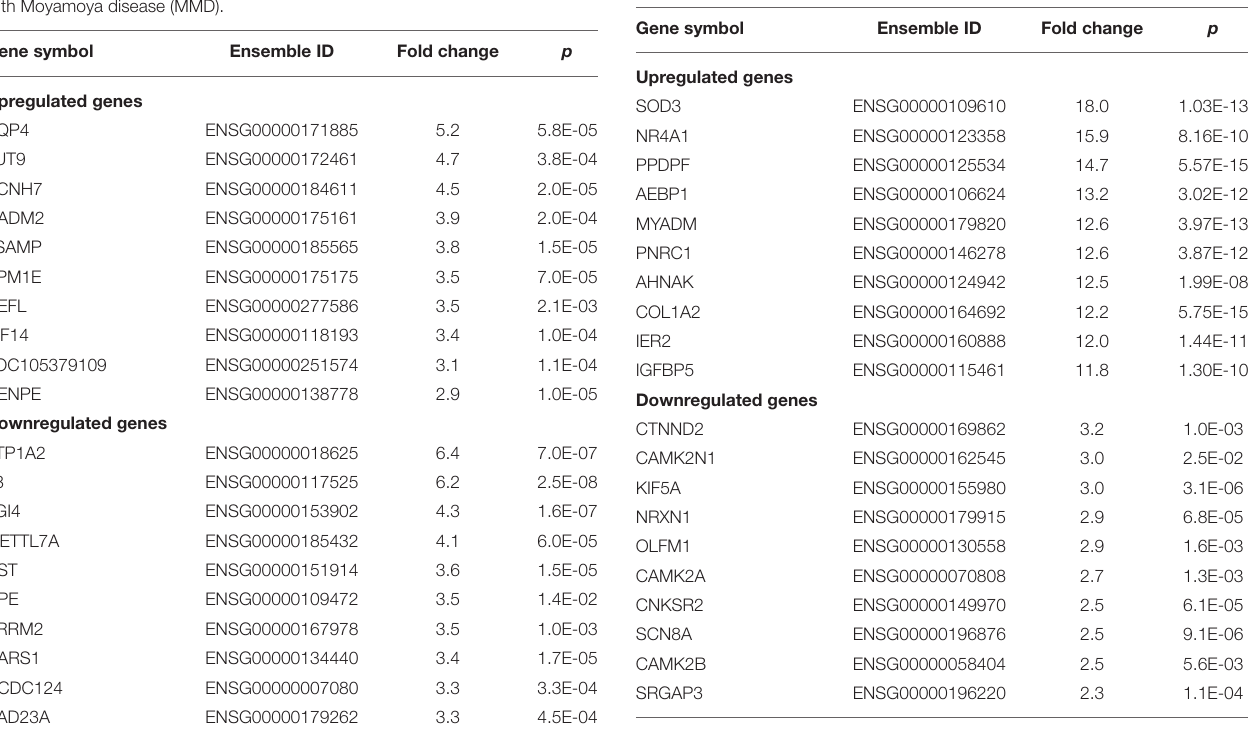
TABLE 3 | Top 10 upregulated or downregulated sex-specific DEGs in MCA samples in women patients with